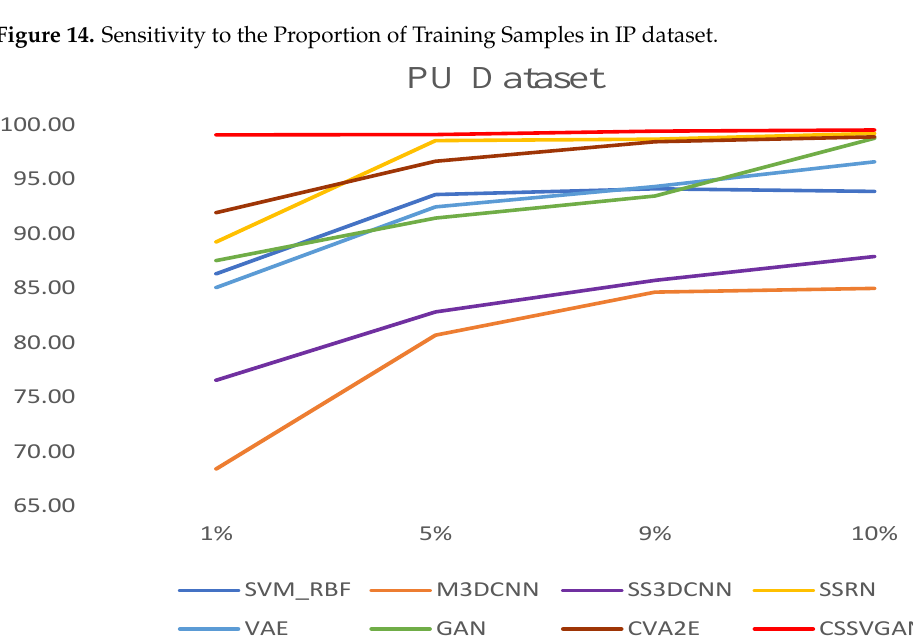
Figure 15. Sensitivity to the Proportion of Training Samples in PU